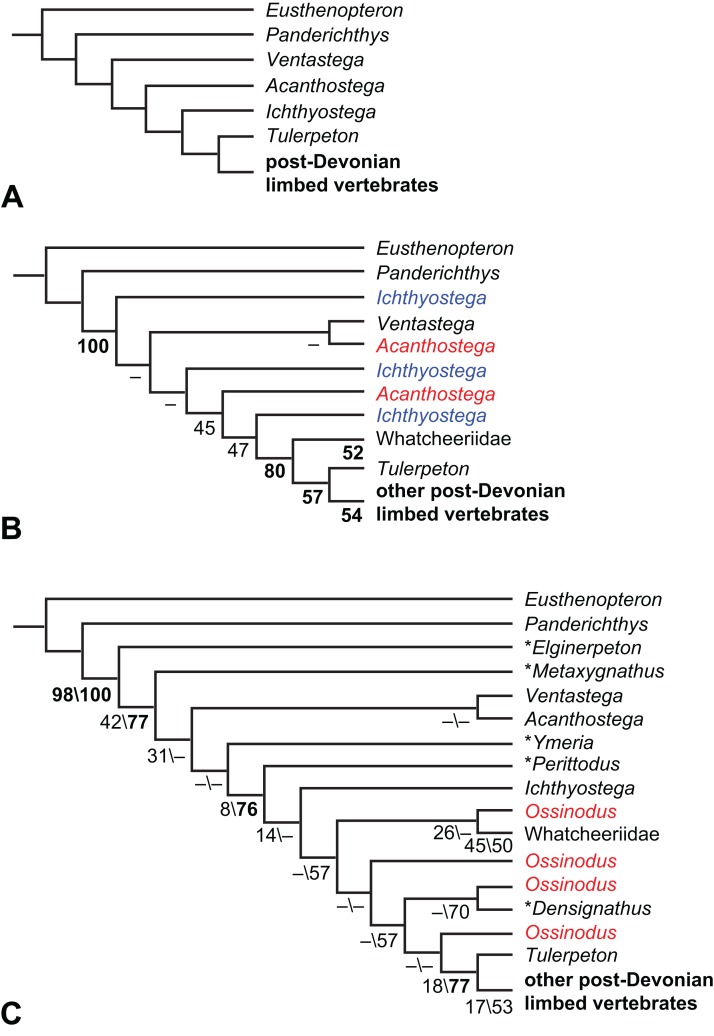
Hypotheses on the relationships of Devonian limbed and possibly limbed vertebrates.(Whatcheeriidae and *Perittodus, which have limbs, are only known from the Carboniferous with certainty.) Equally parsimonious positions of the same OTU are highlighted in color in this and the following figures. (A) RC07 and references therein. (B) Our results from the same taxon sample as RC07 (Analyses R1–R3). Numbers below internodes are BPO, in boldface if 50 or higher. (C) Our results from the expanded taxon sample (R4–R6). Numbers below internodes are BPE\PP, BPE in boldface if 50 or higher, PP in boldface if 75 or higher. Analysis B2 places *Ymeria next to Ventastega (BPE: 19), Acanthostega one node crownward of them (BPE: 11) and *Densignathus one node rootward of Whatcheeriidae (BPE: 13); EB places *Ymeria next to *Metaxygnathus (PP: 58), Acanthostega one node crownward of Ventastega (PP: 76) and *Perittodus one node crownward of Ichthyostega (PP: 58).